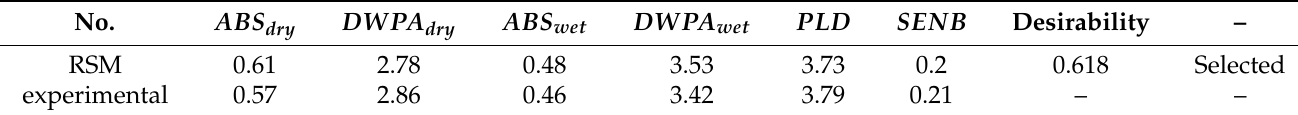
Table 5. Comparison of RSM and test